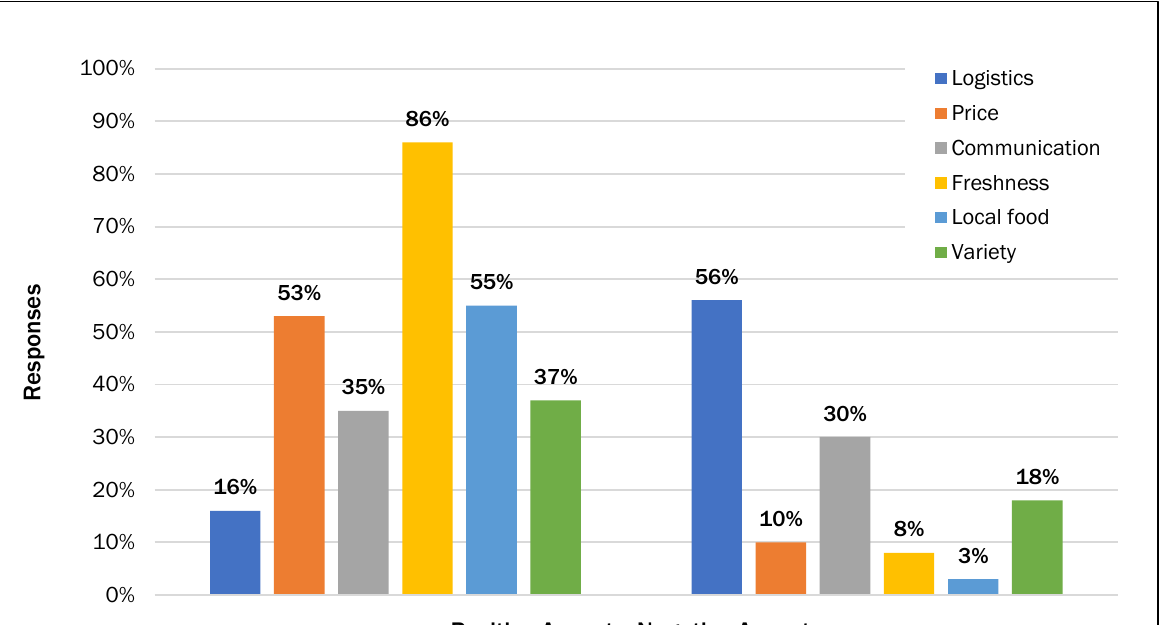
Figure 1. Consumer Perspective on Positive and Negative Aspects of Direct Purchasing from